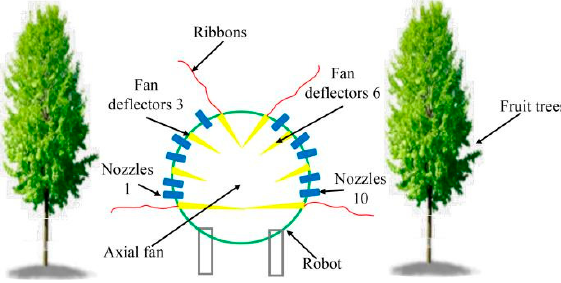
Figure 3. Adjusting the nozzles and fan deflectors. Table 1. Nozzles and fan deflectors’ position.